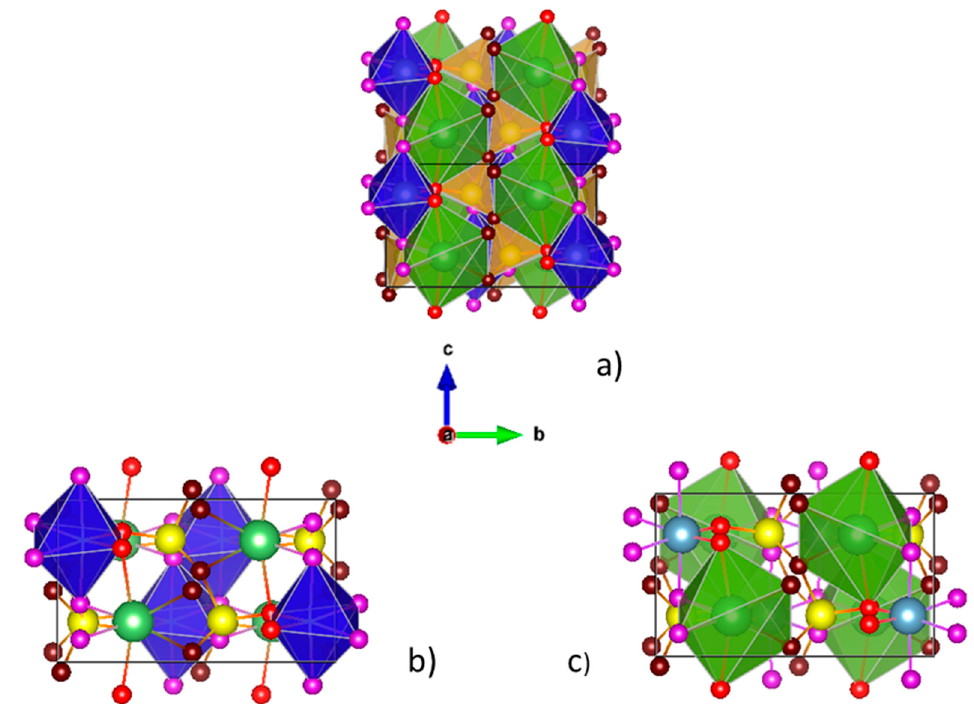
Figure 1. Sketch of spodumene structure on (010) using Vesta 3 program and American Mineralogist Crystal Structure Database. ( a ) Double c unit; ( b ) M1 polyhedron only; ( c ) M2 polyhedron only. SiO 4 tetrahedrons—light brown color; M1 octahedrons—blue color; M2 octahedrons—green color; O1 atoms—magenta balls; O2 atoms—red balls; O3 atoms—brown balls; Si atoms—yellow balls; Al atoms—blue balls; and Li atoms—pale green balls.